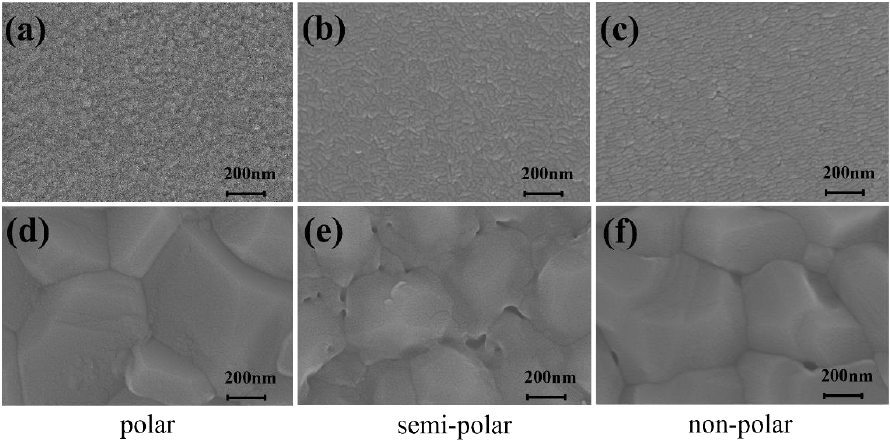
Figure 5. ( a – c ) The surface morphology images of the films without annealing; ( d – f ) the surface morphology images of the films with annealing at 1650 °C. morphology images of the films with annealing at 1650 ◦ C.